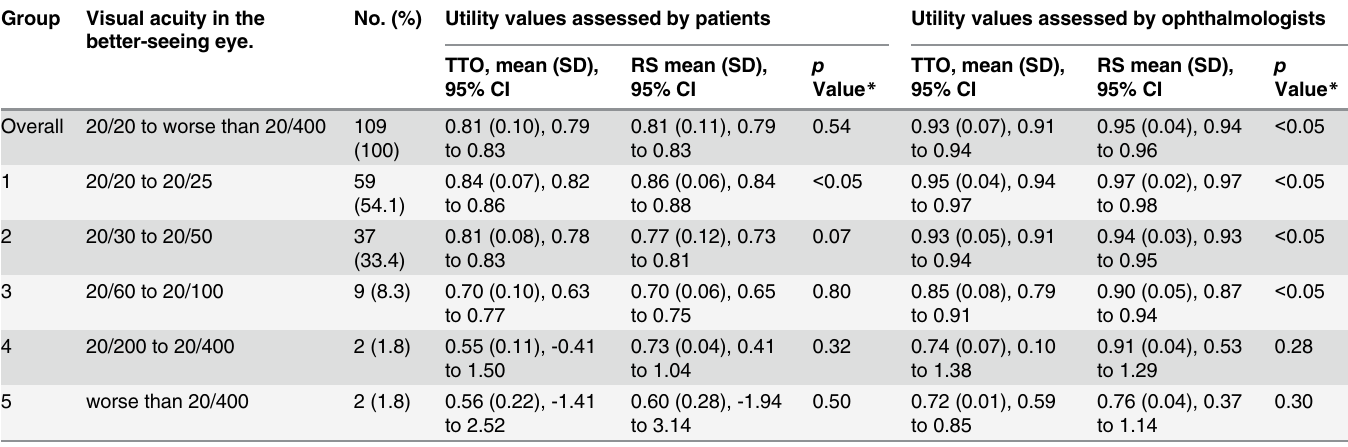
Table 2. Comparison of the time trade-off and rating scale utility values from patients and ophthalmologists. Group Visual acuity in the better-seeing eye.